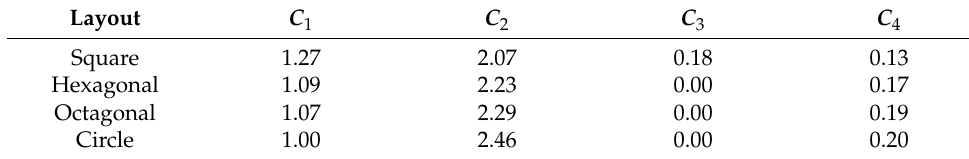
Table 13. Coefficients for current sheet